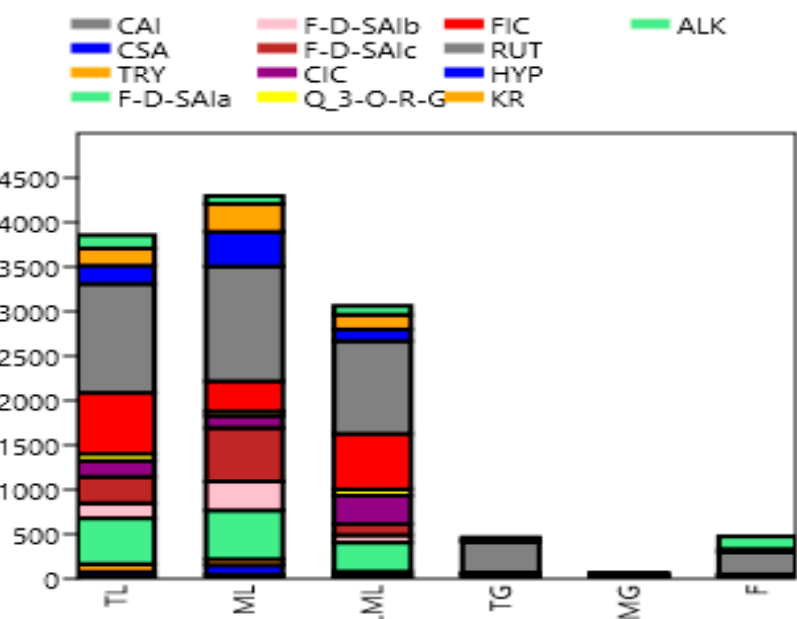
Figure 3. Stacked bar graph of phenolic compounds in amaranth plant (mg/kg). CAI, caffeoylsaccharic acid isomer; CSA, coumaoryl saccharic acid; TRY, tryptophan; F- D -SAIa, feruloyl- D -saccharic acid isomer a; F- D -SAIb, feruloyl- D -saccharic acid isomer b; F- D -SAI c, feruloyl- D -saccharic acid isomer c; CIC, caffeoyl isocitrate; Q 3- O -RG, quercetin 3- O -rhamnosyl-rhamnosyl-glucoside; FIC, feruloyl isocitrate; RUT, rutin; HYP, hyperoside; KR, kaempferol rutinoside; ALK, alkaloid; TL, Tender leaves; ML, mature leaves; LML, late maturity leaves; TG, tender grains; MG, mature grains; F, flowers.